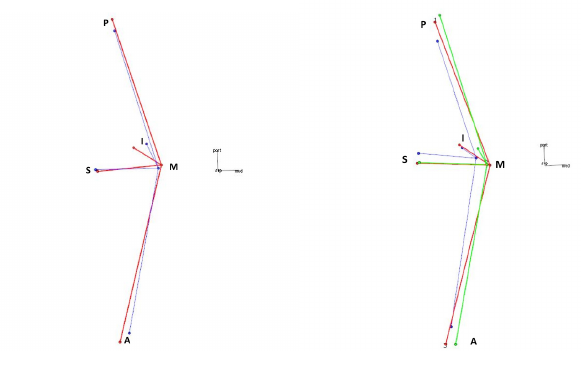
Figure 3. Shape variation based on gender. a) reconstruction of the average for females=blue, males=red) and age. b), reconstruction of the average for patient’s age (< 30 y=blue, patient’s age between 30 and 60 y=red, patient’s age > 60 y= green) according to superior view 3D.